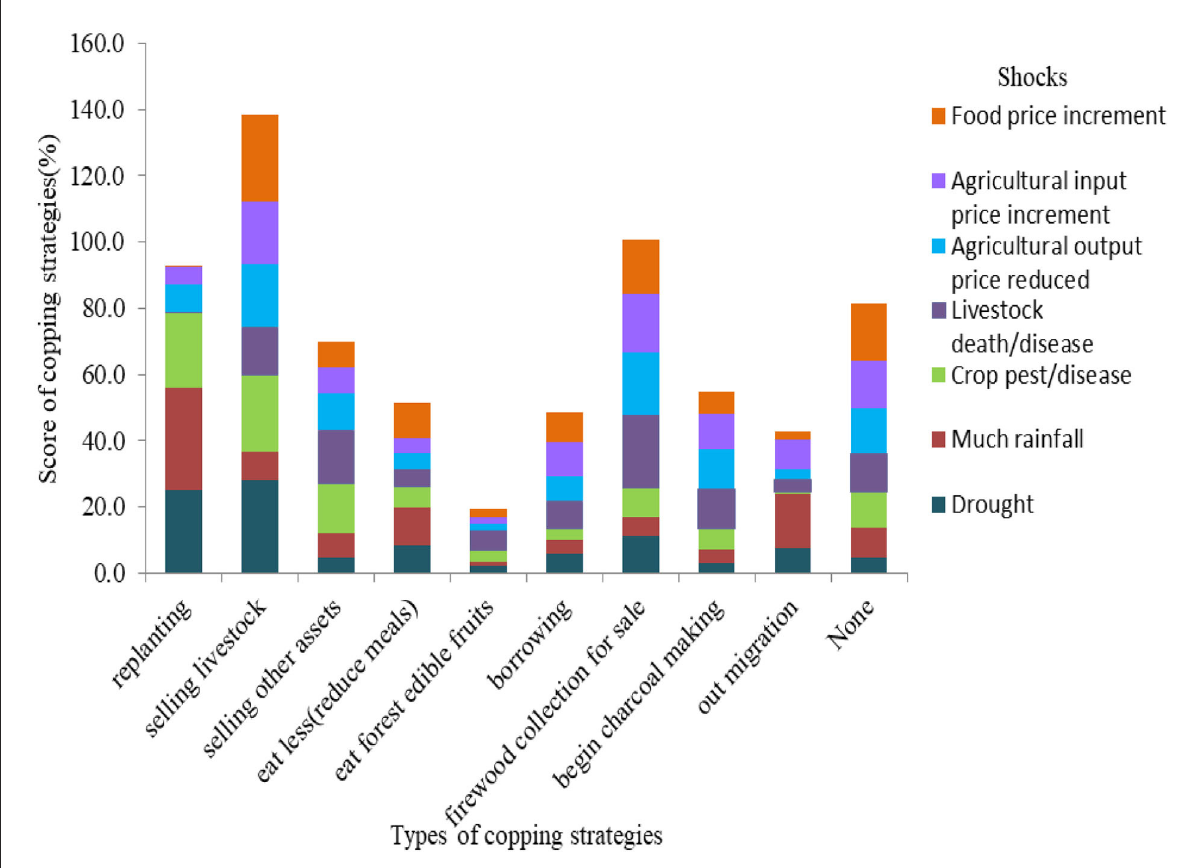
FIGURE7 Coping strategies by households that faced economic